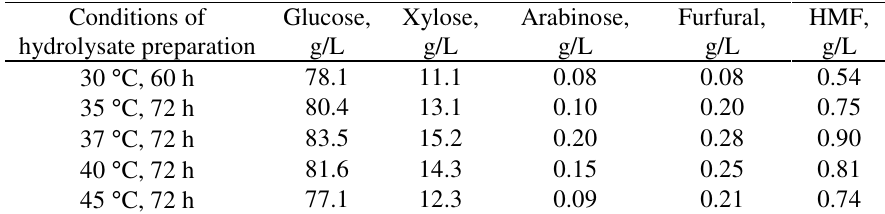
Table 3. Composition of hydrolysate used in the fermentability test